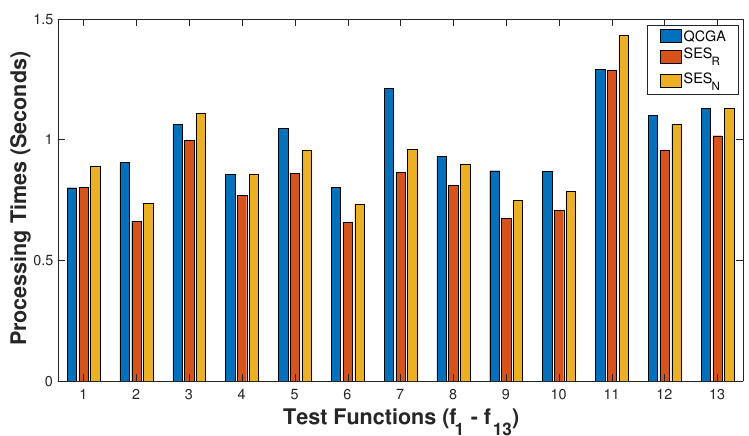
Figure 11. Processing times for proposed methods codes using f 1 – f 13 test functions.